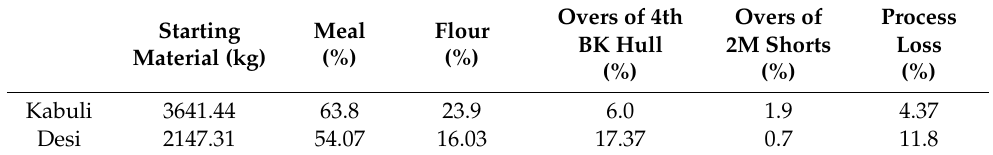
Table 3. Milling yields (% as-is) of kabuli and desi chickpeas from roller